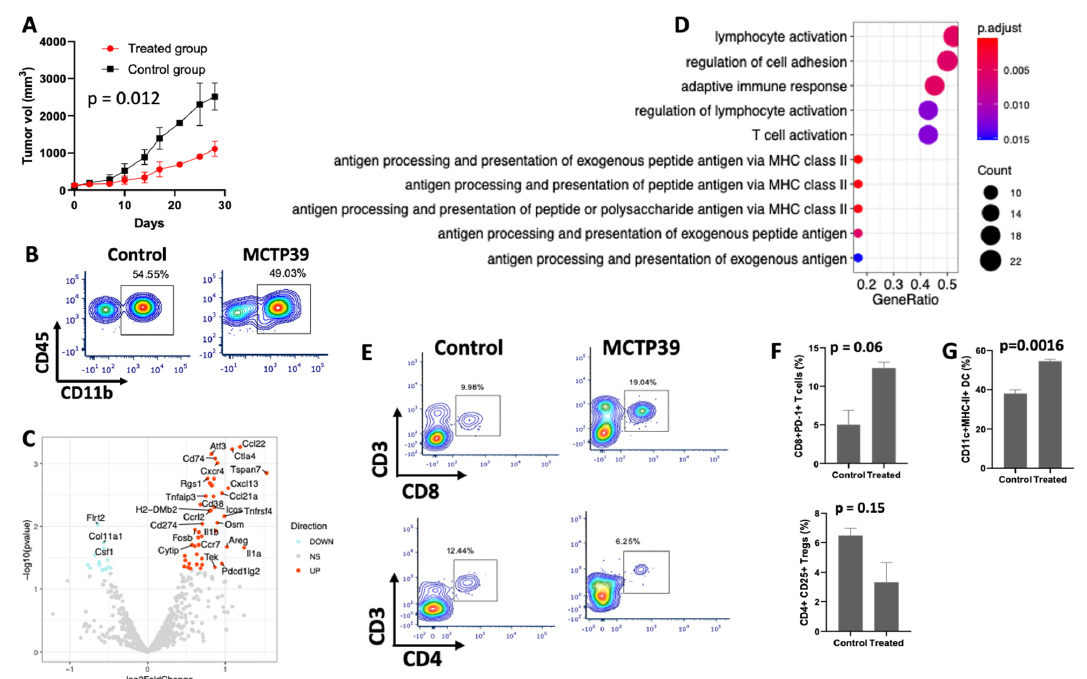
Figure 1. Effect of WHSC1 inhibition in vivo. ( A ) Tumor growth in MCTP39-treated mice. Tumor growth was measured over time in mice grafted subcutaneously with TRAMP C2 cells. Black and red lines indicate control and MCTP39-treated mice, respectively. Each time point reports the average tumor growth in at least two mice. ( B ) Intratumoral CD45 + CD11b + cell abundance in tumors from control and mice treated with MCTP39. Percentage of gated cells over total number of cells is shown. ( C ) Volcano plot showing the results from differential gene expression analysis of the Nanostring data. Red and cyan dots indicate up- and downregulated genes, respectively. Note that not all gene names are shown to reduce visual crowding. ( D ) Functional enrichment analysis of the differentially expressed genes from Nanostring data shown in C using murine gene ontology signatures. ( E ) Flow cytometry analysis of CD3 + CD8 + and CD3 + CD4 + T cells in control (left) and treated (right) samples. ( F ) Quantification of PD-1+ CD8 + T cells (top) and CD4 + CD25 + Tregs (bottom). ( G ) Quantification of CD11c + MHC-II + dendritic cells. Each bar represents the mean and SD of at least two biological replicates. p values were calculated with Students’ t test.